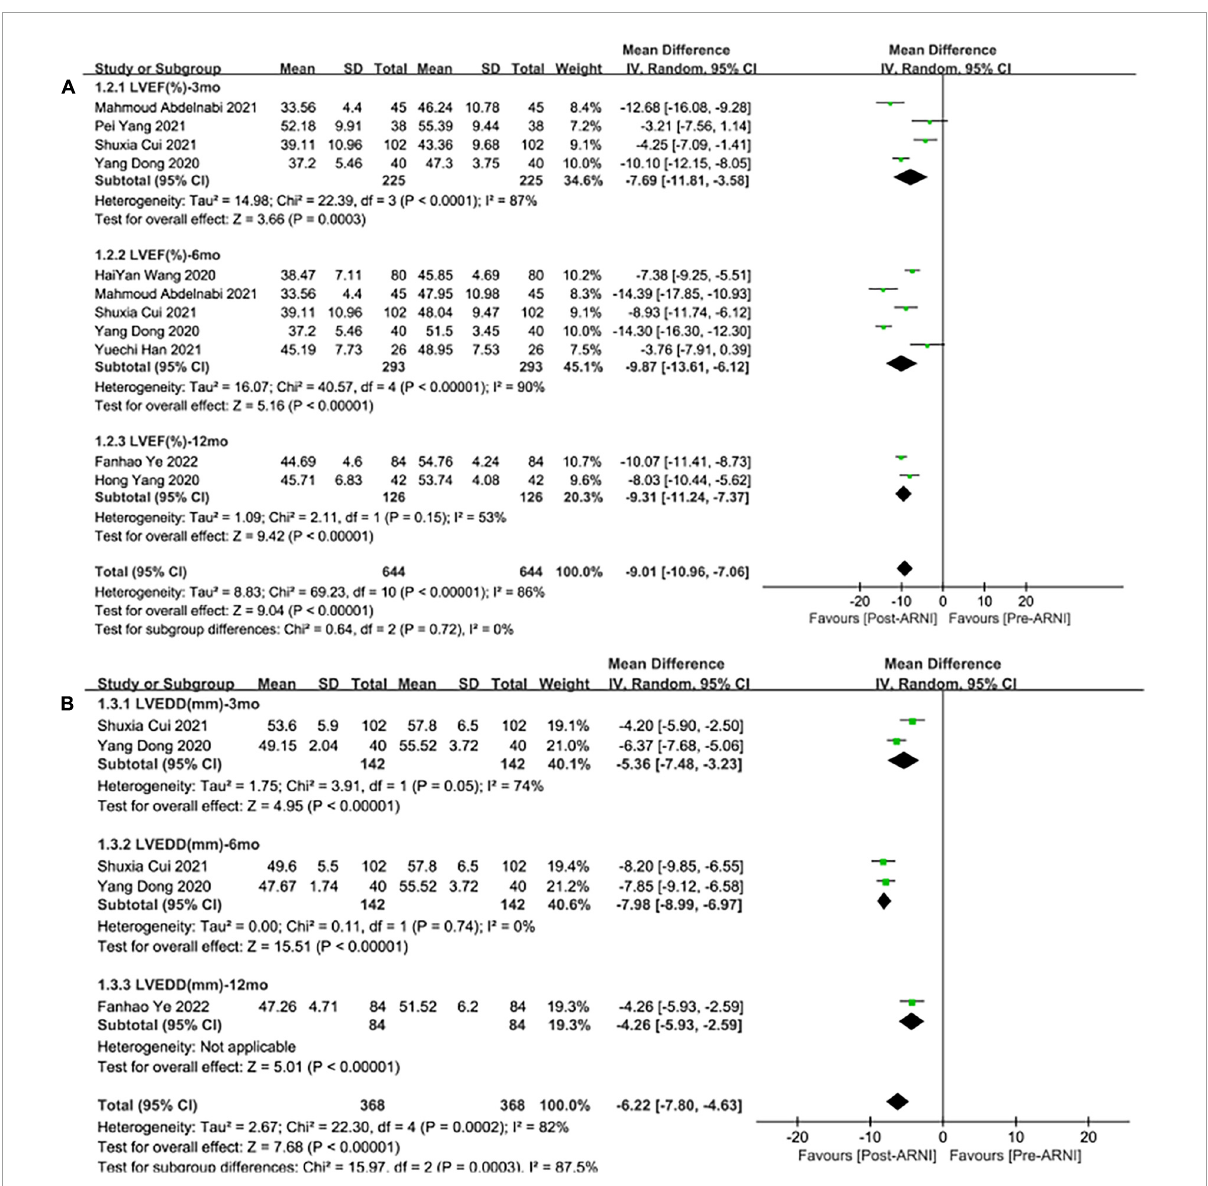
FIGURE4 Subgroup analysis of ARNI effects on CRR indices according to follow-up periods (1). (A) Subgroup analysis on left ventricular ejection fraction, (B) subgroup analysis on left ventricular end-diastolic